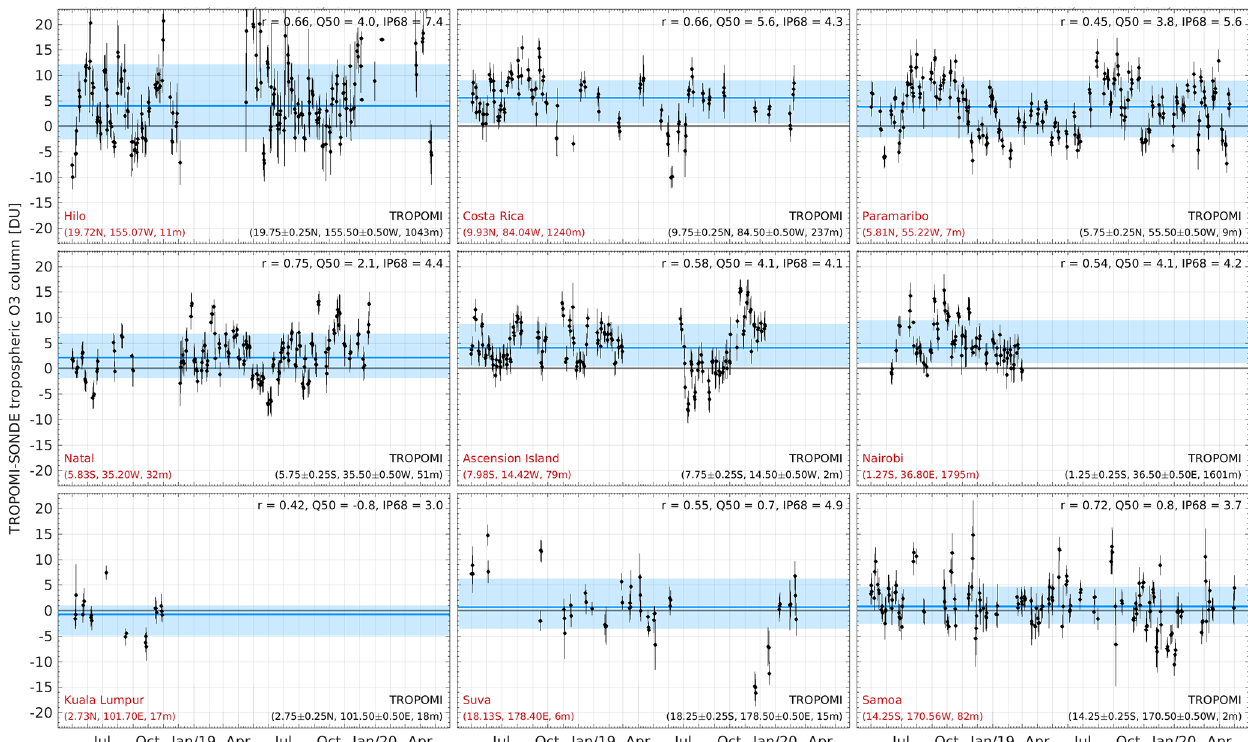
Figure 4. Time series of the difference between spatially and temporally co-located TROPOMI and ozonesonde tropospheric ozone column data over nine SHADOZ sites. Positive values indicate that TROPOMI overestimates the ozonesonde value. Blue line and area show median (Q50) and 68% interpercentile (IP68) over the entire